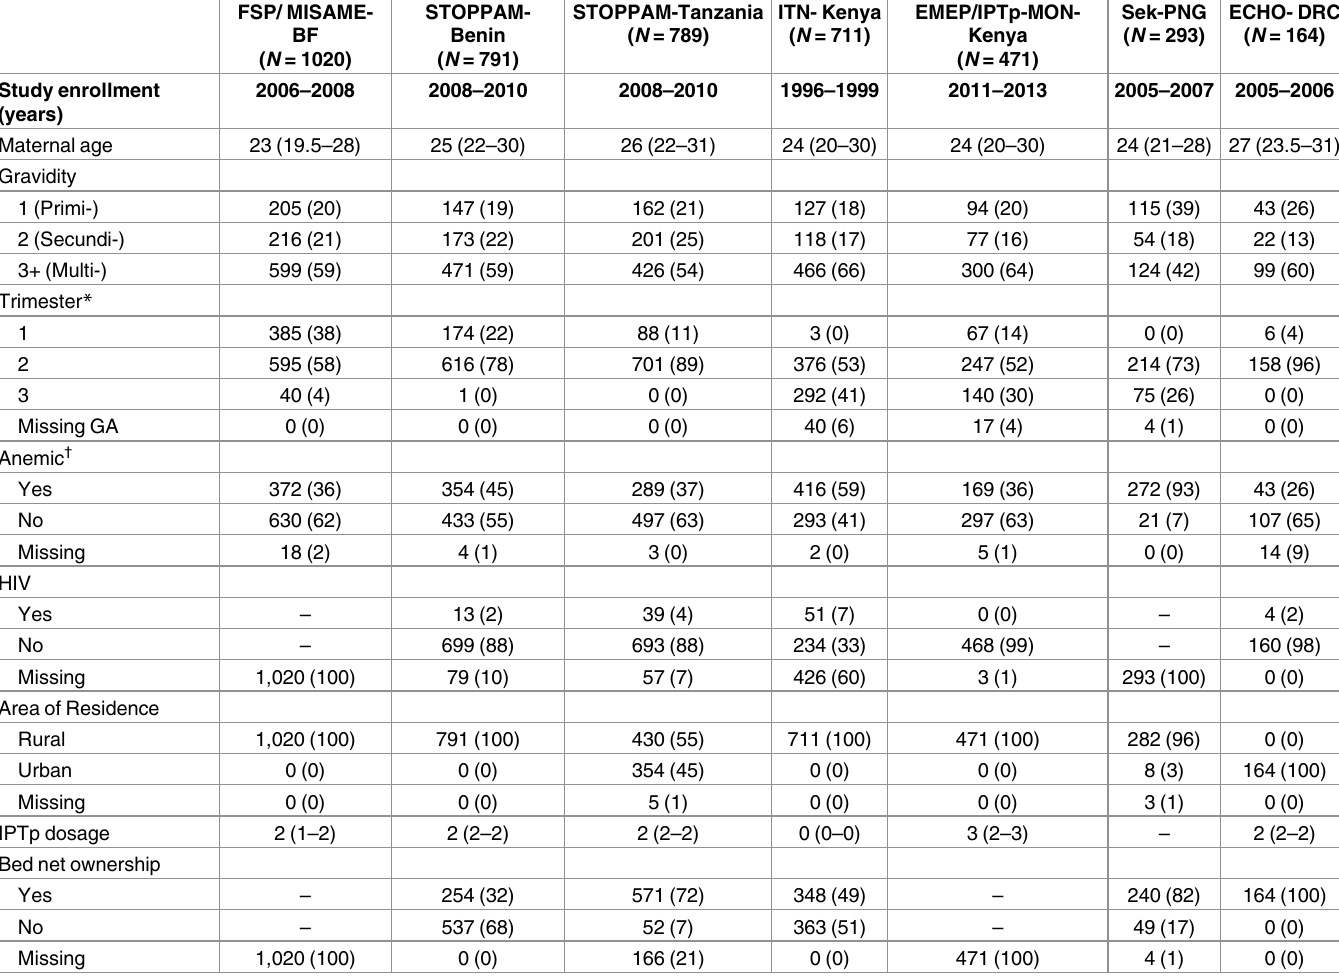
Table 2. The characteristics of women included in the Maternal Malaria and Malnutrition (M3) initiative from the following 7 out of 13 M3 studies: FSP/MISAME-BF, STOPPAM-Benin, STOPPAM-Tanzania, ITN-Kenya, EMEP/IPTp-MON-Kenya, Sek-PNG, ECHO-DRC. FSP/ MISAME-